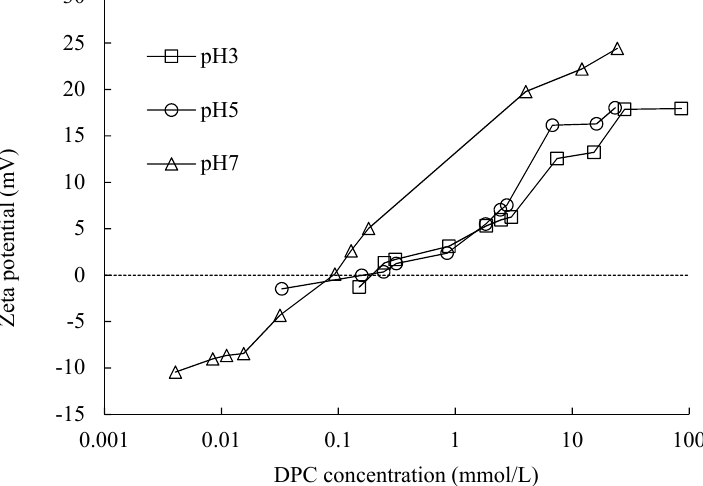
Figure 9. Zeta potential as a function of pH under different electrolyte concentrations.